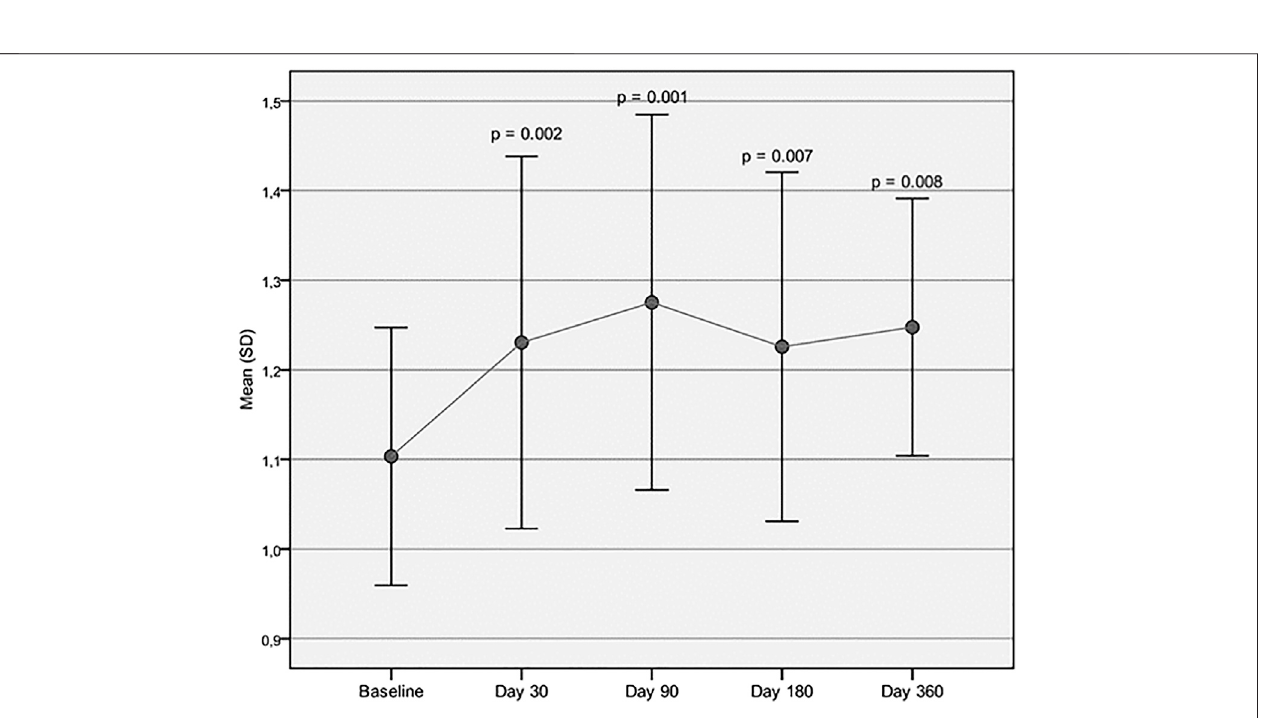
injection, as well as at every other time point, con fi rming the ef fi cacy of the treatment. The functional knee improvement increased through the entire follow-up period of interest ( Table 1 ).